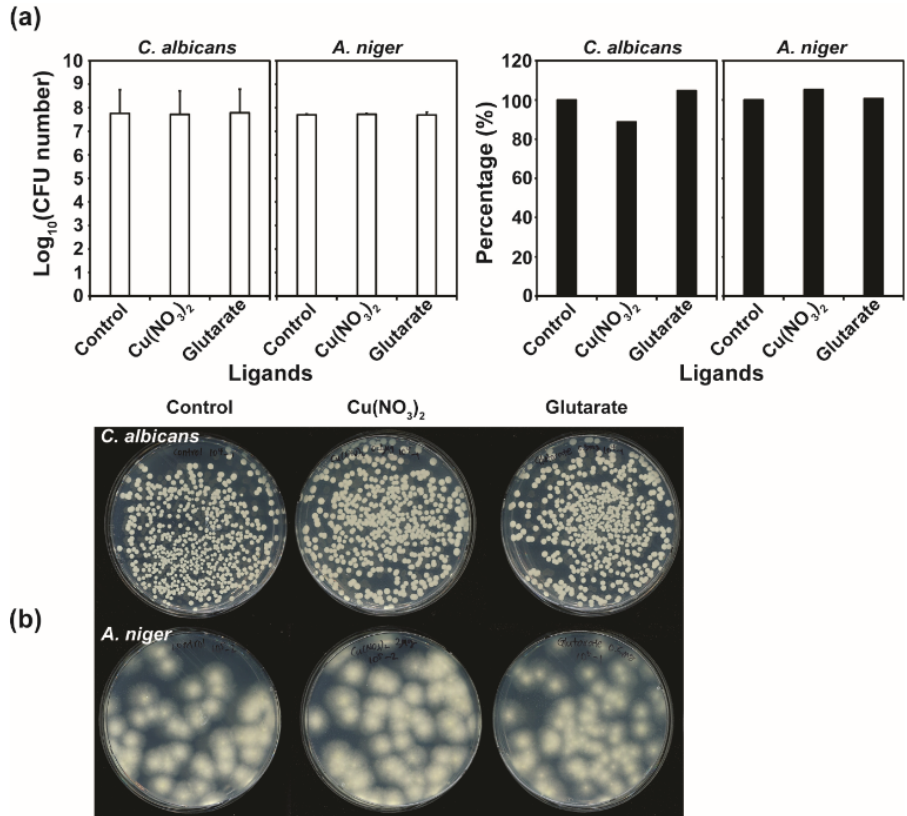
Figure 5. Effect of Cu(NO 3 ) 2 and glutarate. ( a ) Fungal viability indicated as log 10 (CFU number) and relative percentage after treated with each ligand for 1 day. The concentrations of Cu(NO 3 ) 2 and glutarate used in the treatment were 0.1 μ g/mL and 0.25 mg/mL, respectively. Each value in log 10 (CFU number) was an average of three replicate measurements, and relative percentage was calculated using the average value of CFU number. ( b ) Pictures of plates showing CFUs of C. albicans and A. niger on the PDA plates 1 day after treatment.